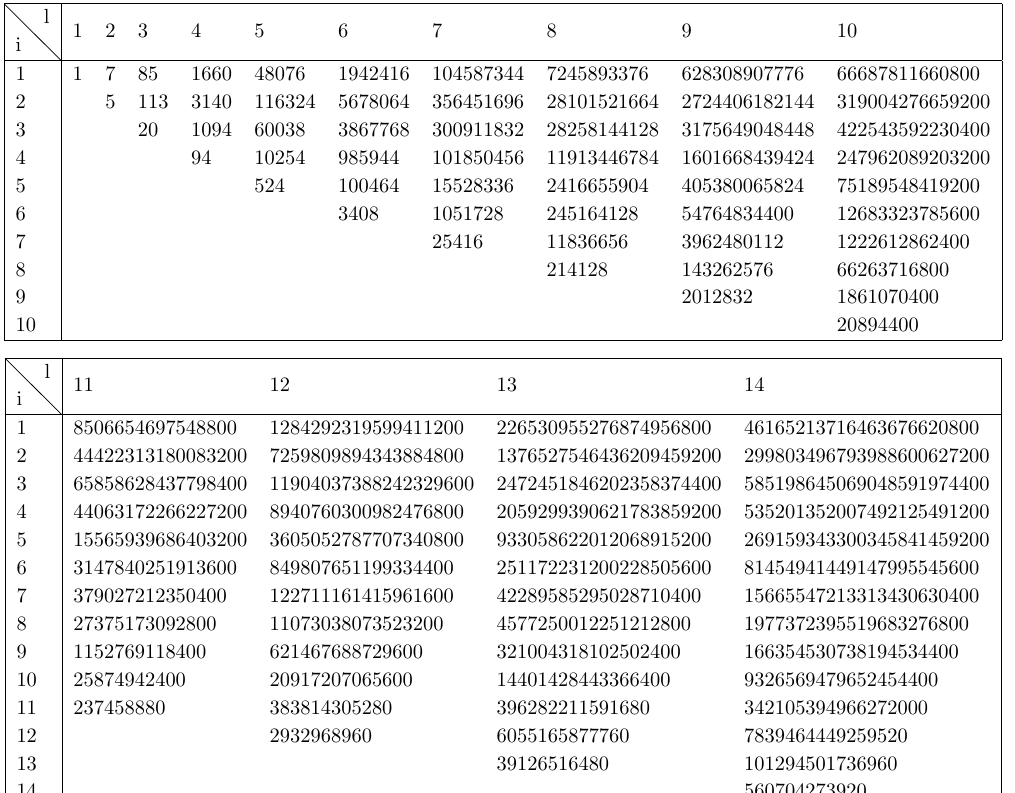
Table 1 . Table of the coe(cid:14)cients a l